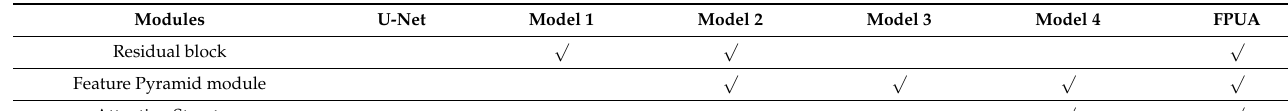
Table 4. Modules included in different models.